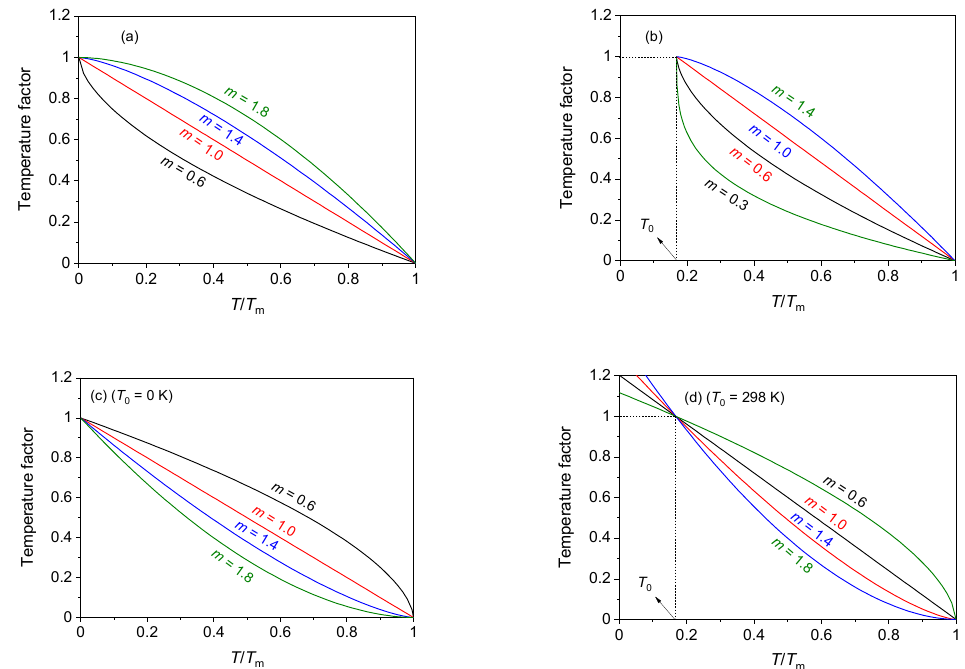
Figure 8. Changes in ( a ) absolute temperature-based TF; ( b ) limited range TF ( T 0 = 298 K); flexible TF (( c ) T 0 = 0 K and ( d ) T 0 = 298 K) as a function of T / T m ( T m = 1773 K). These TFs coerce zero flow stress at melting point.